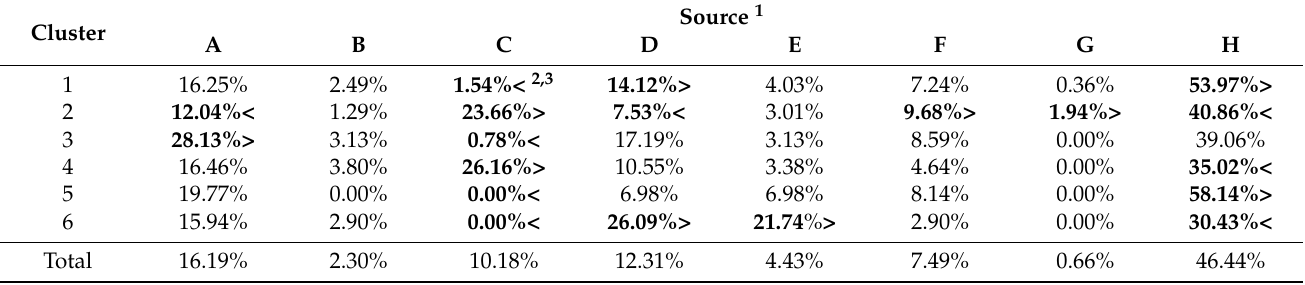
Table 11. Distribution clusters by the source of reporting of all the sequences.